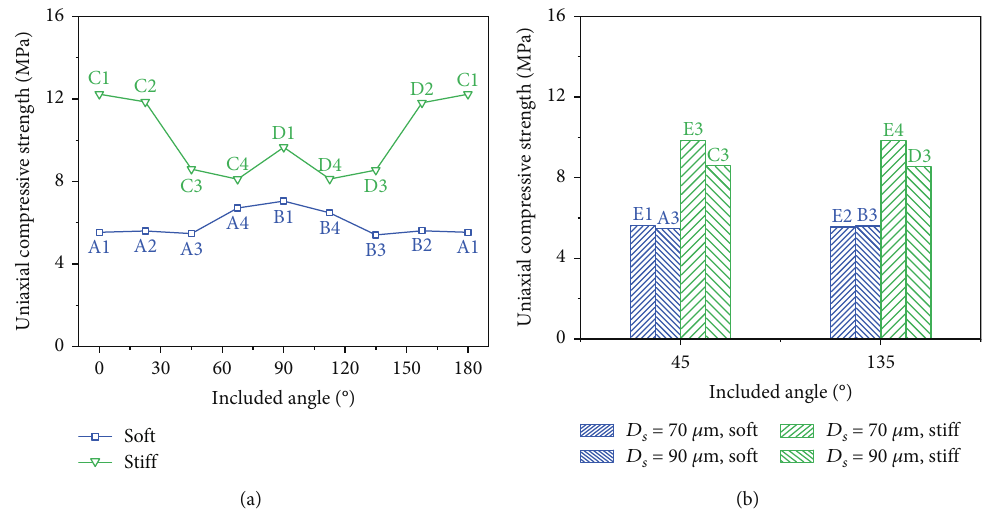
Figure 12: Uniaxial compressive strength (UCS) of the structures presented in Figure 11 with di ff erent (a) inclinations and (b) spacings ( D ). The label “ soft/sti ff ” represents the structure mainly comprising the porous matrix or nonclayey minerals. The labels on the data correspond to the sub fi gure labels in Figure